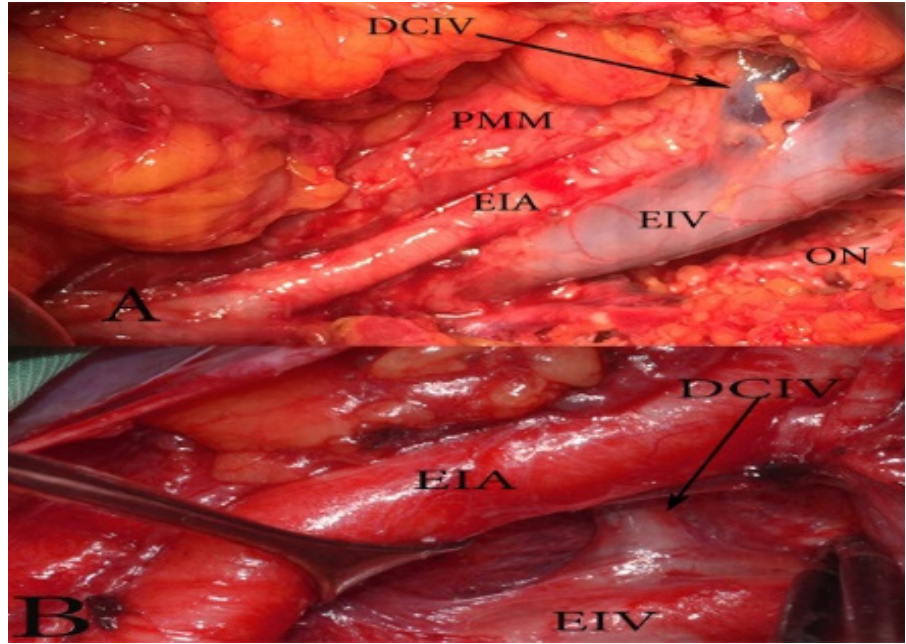
Figure 16. The deep circumflex iliac vein (DCIV) normal anatomy ( A ) and variation ( B ) (open surgery, left pelvic sidewall). ( A ) The DCIV runs over the EIA and drains into the EIV. ( B ) The DCIV passes under the EIA and drains into the EIV.